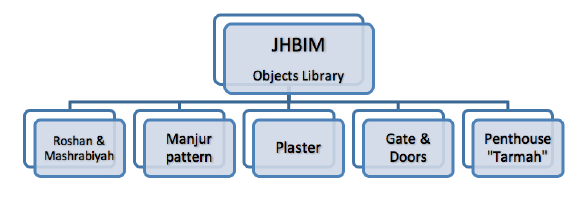
Figure 6. JHBIM objects library layout.